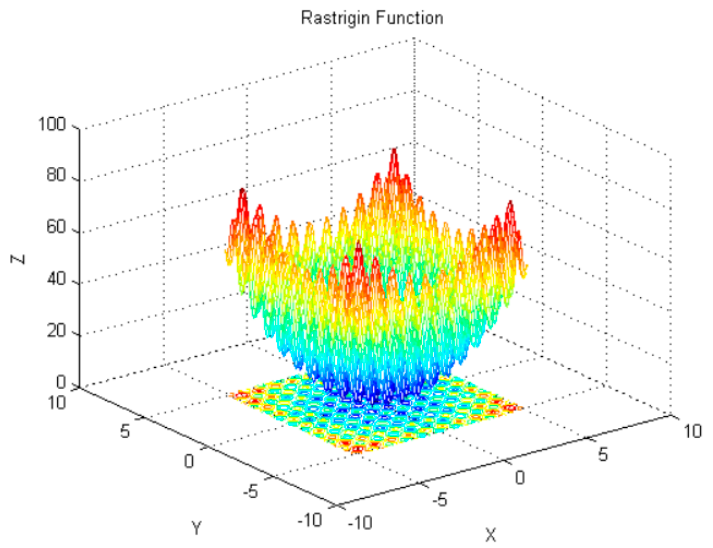
Figure 8. Three-dimensional graph of the Rastrigin function.